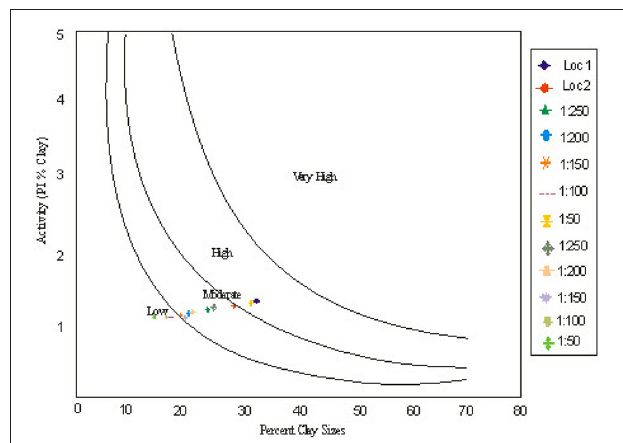
FIGURE 6 | Classification chart for swelling